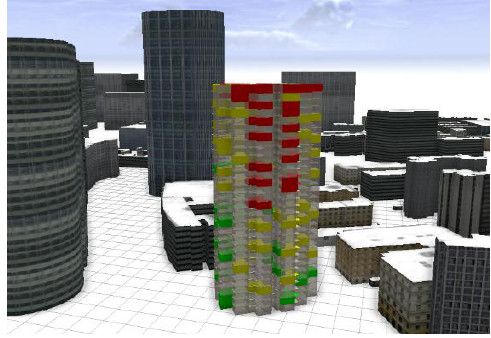
Figure 10. Rendered Chart of Sunlight